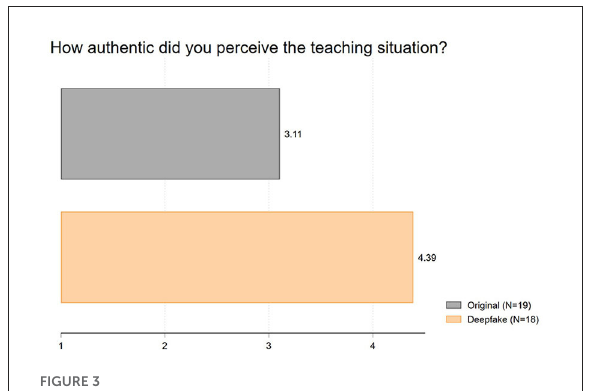
FIGURE3 Mean values of